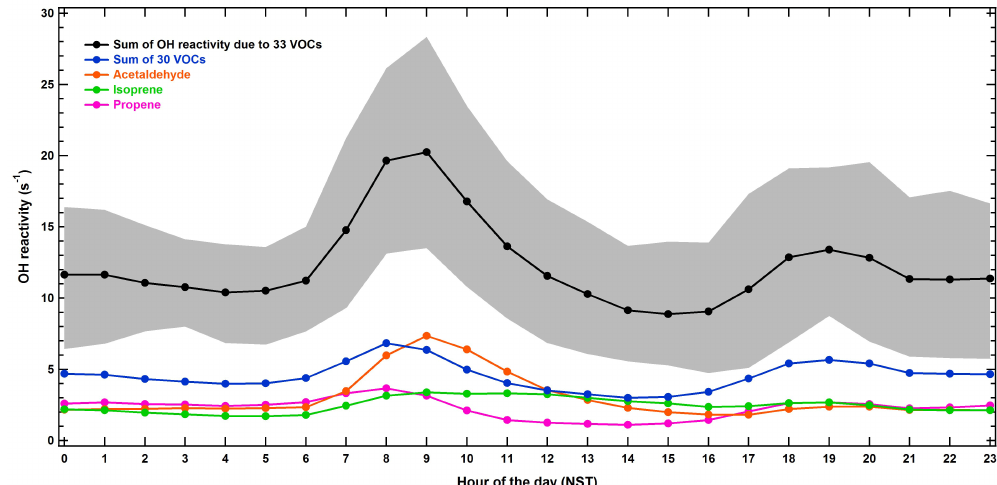
Figure 9. Diel profiles of the calculated total VOC OH reactivity (with 10th and 90th percentile contributions represented by the grey shaded region) and the major VOC